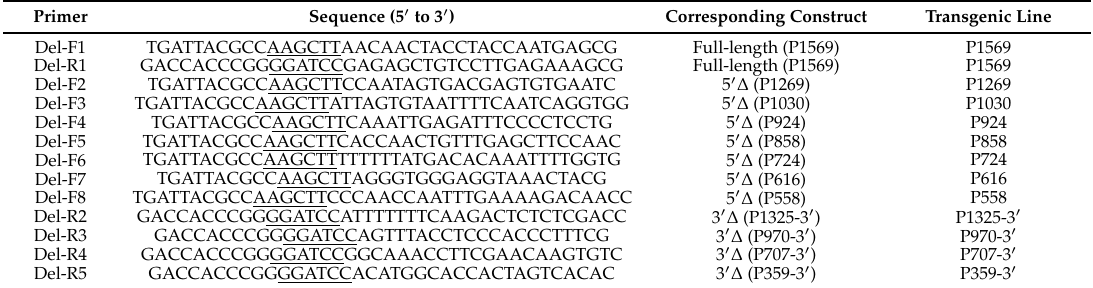
Table 2. Sequences of primers used to amplify the DlRan3B promoter deletion constructs.